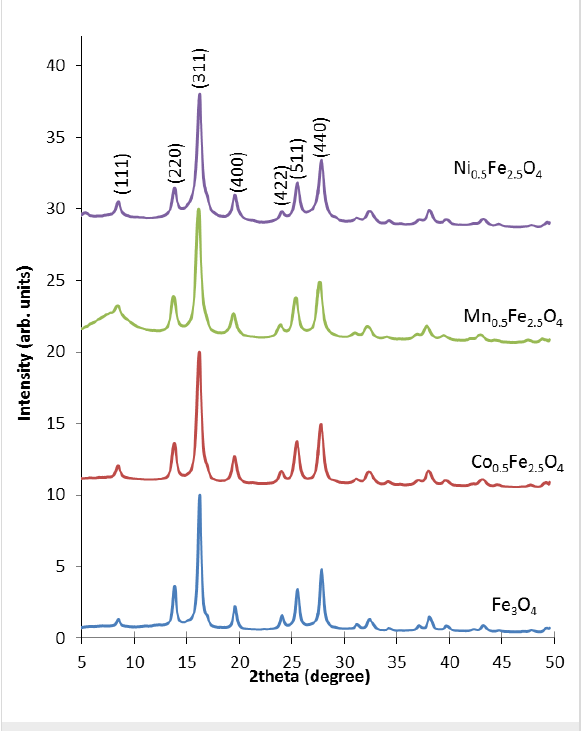
Figure 3: X-ray spectra of ferrite nanoparticles.